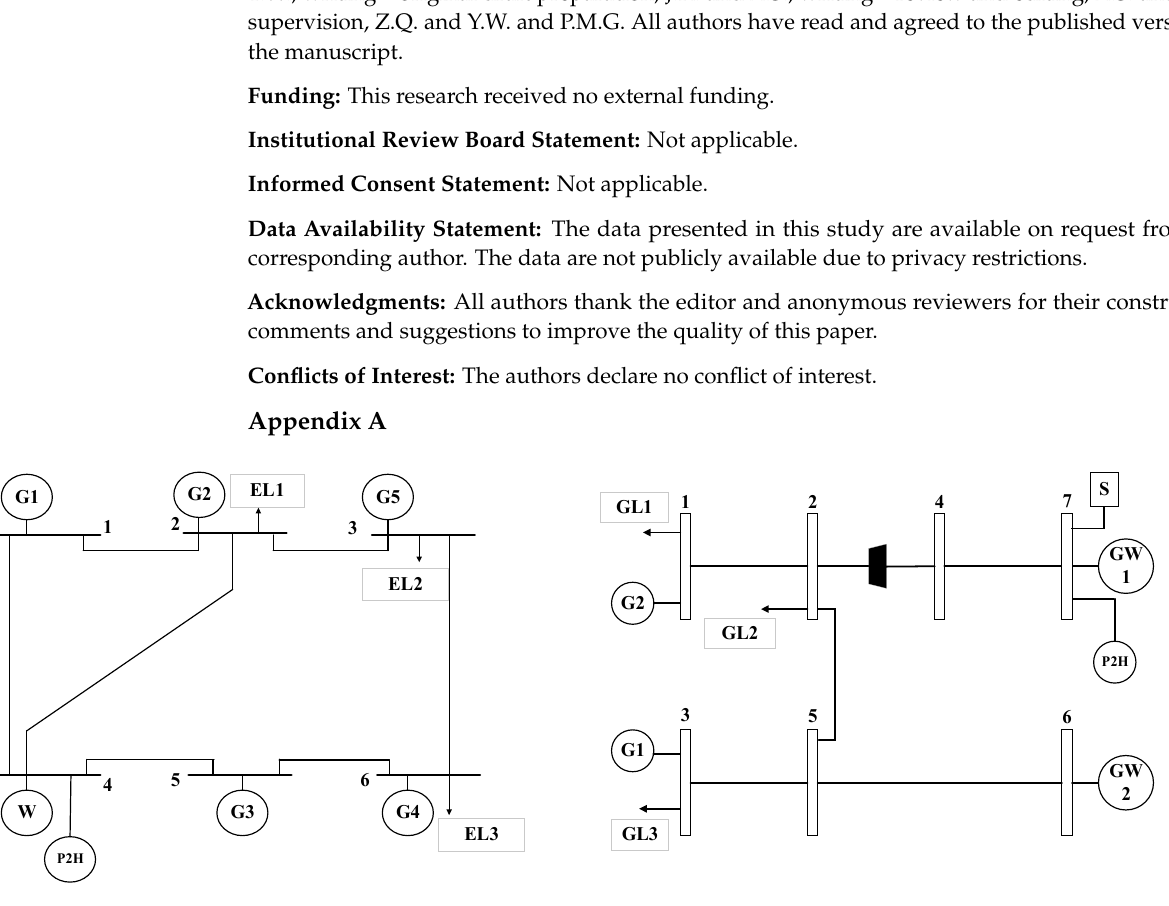
Figure A1. Node diagram of 6-node power system and 7-node natural gas system. Table A1. Cost parameters of generators.